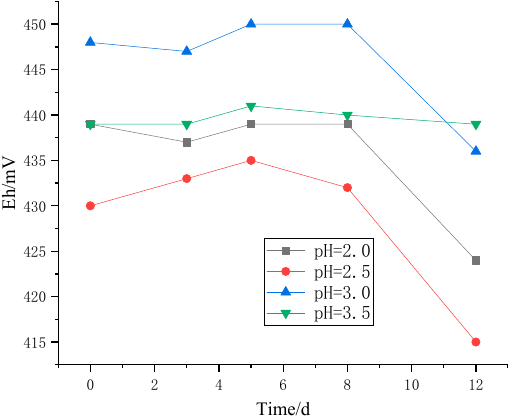
Figure 9. Variation in H 2 O 2 as oxidant Eh with time ( c (Fe(II)) is 2 g/L).